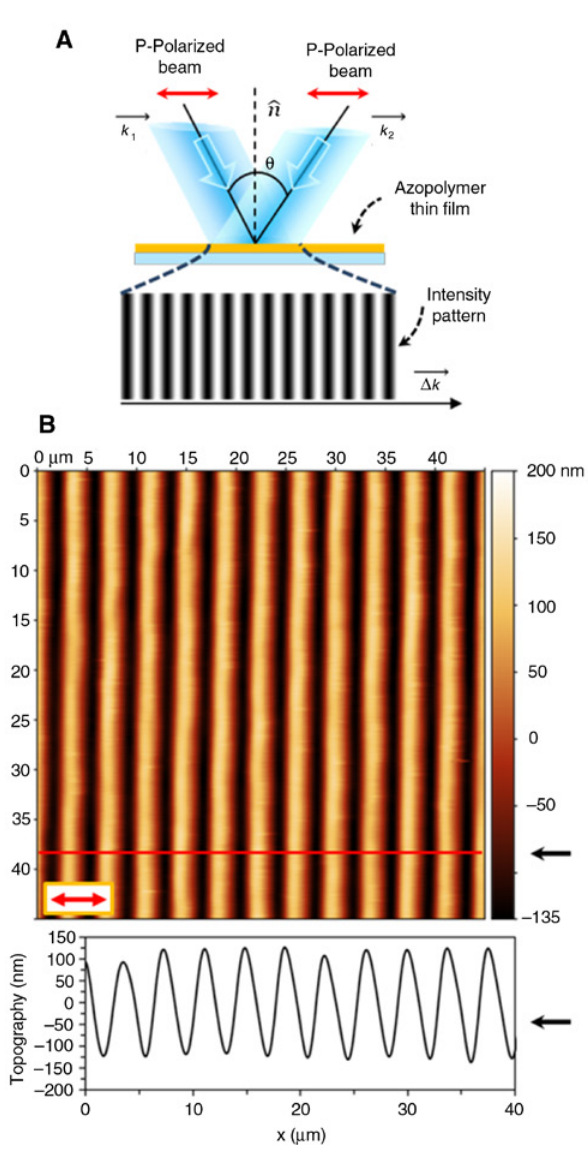
Figure 2: The SRGs induced onto an azopolymer film by the irradiation of an intensity pattern produced by two interfering p-polarized beams. (A) Schematic representation of the typical illumination configuration used for the inscription of SRGs. (B) AFM image and amplitude topo- graphic profile (traced along the red line) of the SRGs in (A). The red arrow indicates the polarization direction of the two interfering